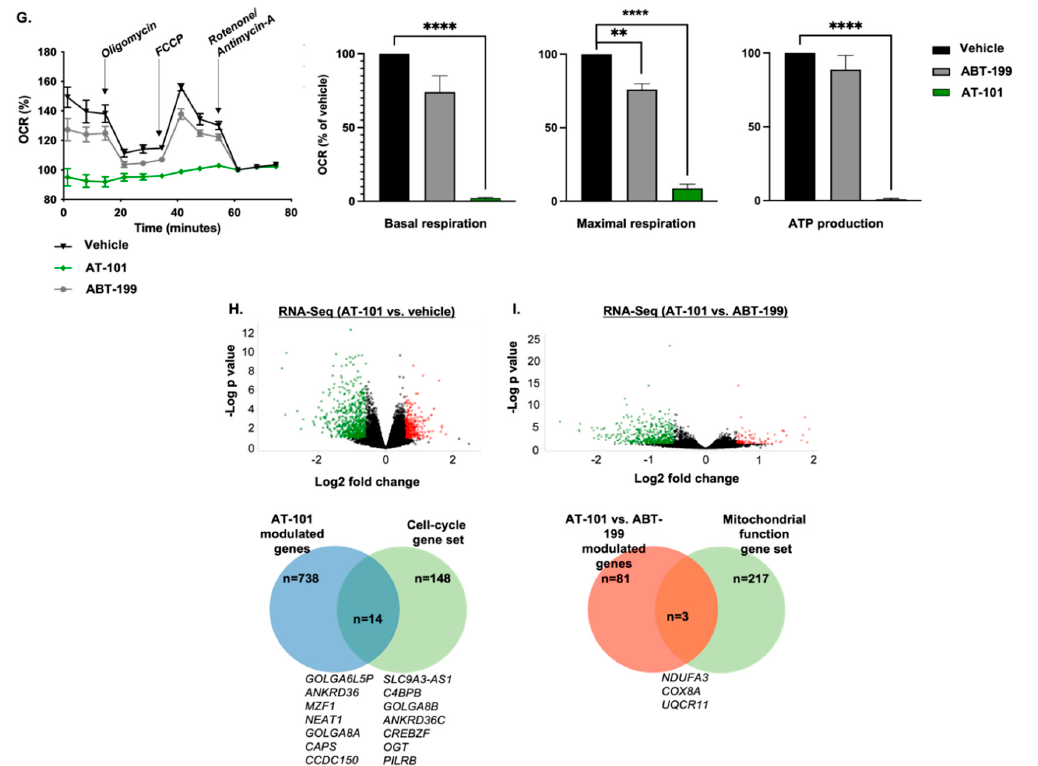
Figure 1. AT-101 induces myeloma cell death and compromises mitochondrial functions. ( A ) Multiple myeloma (MM) cell lines were treated with increasing concentrations of AT-101 or ABT-199 for 72 h and IC50 for each drug was determined by CellTiter Glo 2.0 assay. The IC50 of AT-101 in KMS-11 and RPMI-8226 cell was 3.9 uM and 2.0 uM, respectively. The IC50 of ABT-199 in these cells was 9.3 uM and 8.1 uM, respectively, which was significantly higher than that of AT-101 ( p = 0.002). ( B , C ) MM cell lines were treated with DMSO (vehicle) or AT-101 (5 uM) for 24 h and 48 h and cell death was determined by staining with annexin-V + PI followed by flow cytometry analysis. A representative contour plot displaying cell death in RPMI-8226 cells is shown in the panel on the right. ( D ) Apoptosis was assessed in bone marrow mononuclear cells from MM patients treated ex vivo with AT-101 or DMSO for 24 h, followed by labeling with an anti-CD138 antibody, annexin-V and analysis by flow cytometry. ( E , F ) Mitochondrial outer membrane permeability was measured in KMS-11 and RPMI-8226 cells treated with AT-101 (5 uM, 24 h), which showed a significant increase in permeability (decrease in JC1 dye relative fluorescence units [RFU]) measured over a 1 h period. The uncoupling agent CCCP was used as an assay positive control. ( G ) Mitochondrial respiration and bioenergetics was measured in KMS-11 cells treated with AT-101 (5 uM, 24 h) or ABT-199 (5 uM, 24 h) and from which basal respiration, maximal respiration and mitochondrial ATP production was calculated. RNA-seq was performed to determine changes in transcriptome of KMS-11 cells exposed to AT-101 or ABT-199 (1 uM, 24 h). Volcano plots show genes differentially and significantly expressed between cells treated with ( H ). AT-101 (vs. DMSO) and ( I ). AT-101 vs. ABT-199. Pathway analysis was performed and identified 14 genes within the Cell cycle geneset that were differentially altered in AT-101 vs. DMSO cells ( p < 0.001) and 3 genes within the Mitochondrial function geneset differentially expressed between AT-101 vs. ABT-199 ( p < 0.001). Pre-/Post- plots show individual data points (each point average from a single experiment). Bar graphs show data presented as mean ± SD. Mitochondrial membrane potential Each experiment was performed three times in triplicate, except for the mitochondrial bioenergetics assay (conducted three times with 6 replicates) and those performed on primary MM samples. For apoptosis assessment in MM patient CD138+ cells, DMSO-treated samples were grouped together as “Control” and AT-101-treated samples were group together as “Treatment” and unpaired T test was applied (type 2 = two sample equal variance- homoscedastic). (* p < 0.05; ** p < 0.001, *** p < 0.001, **** p <